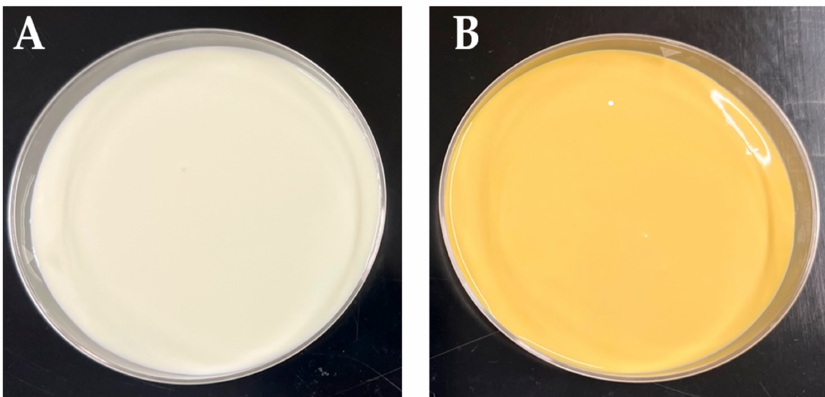
Figure 3. Yogurt products. ( A ) CY—Control yogurt without fucoxanthin at week 0; ( B ) FXY—Yogurt with fucoxanthin at 0.052 mg/g of yogurt mix at week